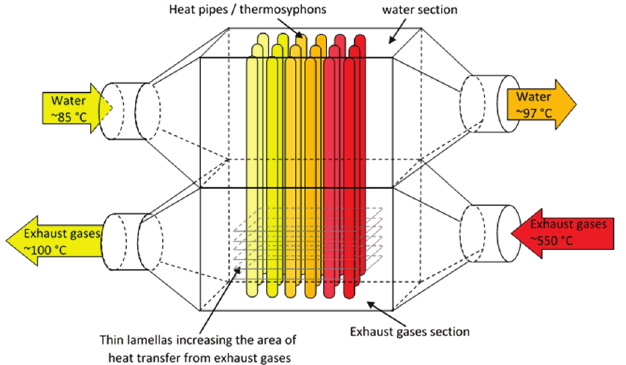
Fig. 3. Heat exchanger concept using heat